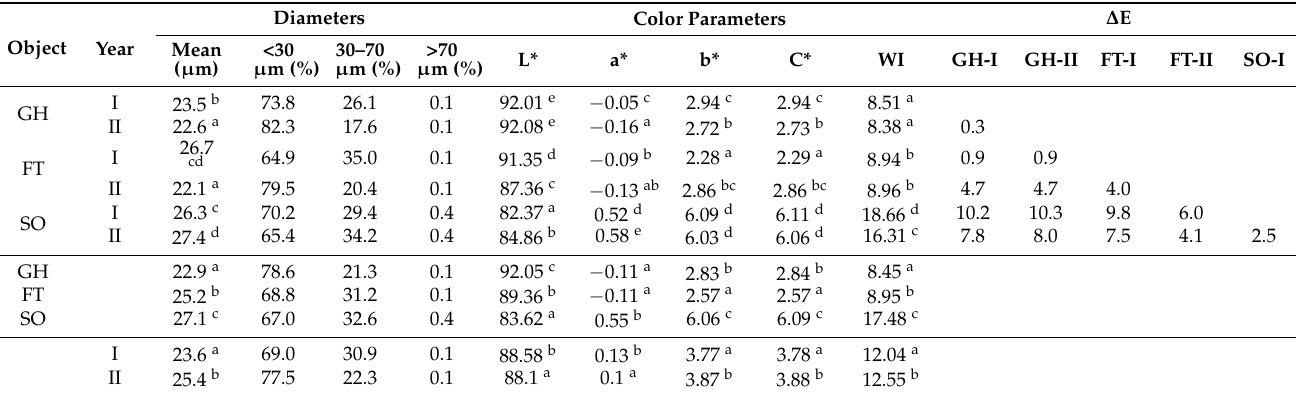
Table 2. Color parameters and equivalent diameters of the potato starch